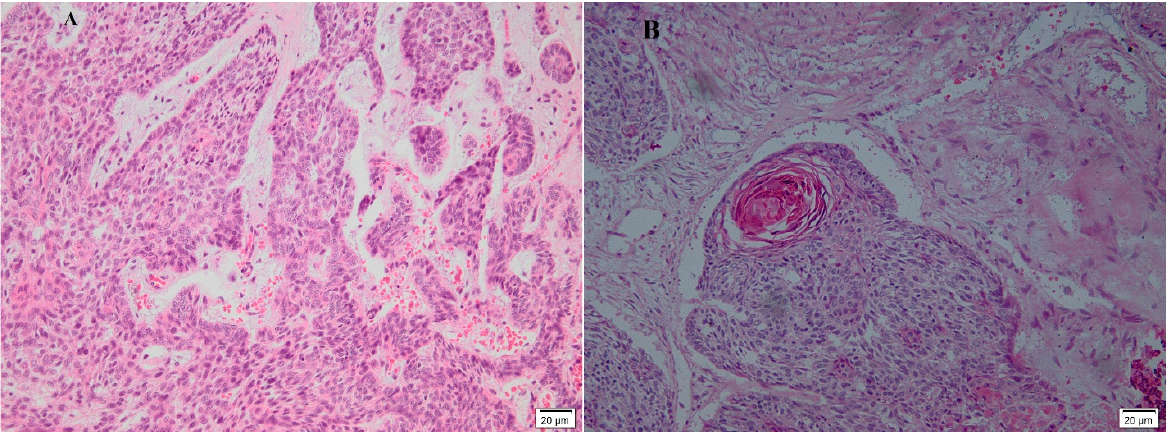
Figure 2. A histopathology picture of basal cell carcinoma showing dermal basaloid malignant nodular masses in the dermis with peripheral palisading and cleft seen area (H&E, 200 × ), ( A ): Myxoid stroma appears. ( B ) The cleft is obvious around the tumor.